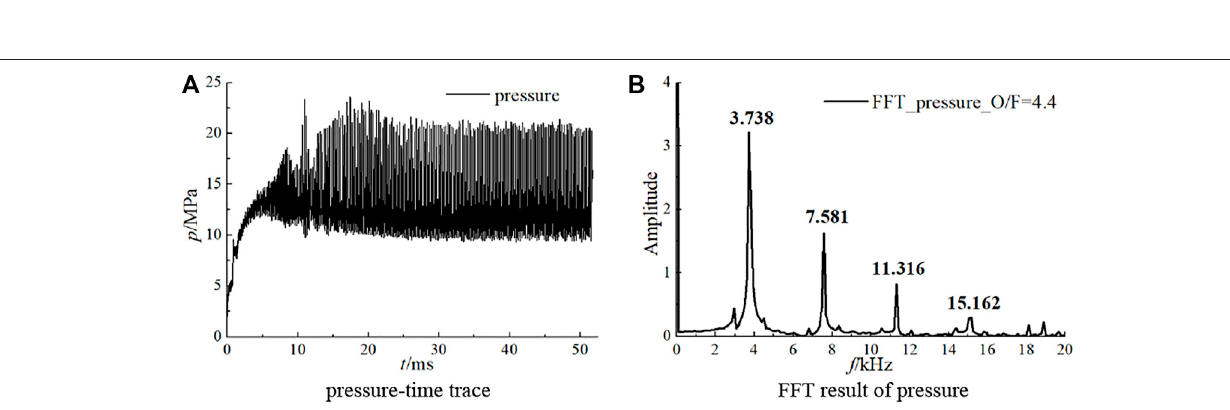
FIGURE 10 | Pressure history and its FFT result of case2 (probe is near the wall and 50 mm downstream from injector faceplate). (A) pressure-time trace. (B) FFT result of pressure.